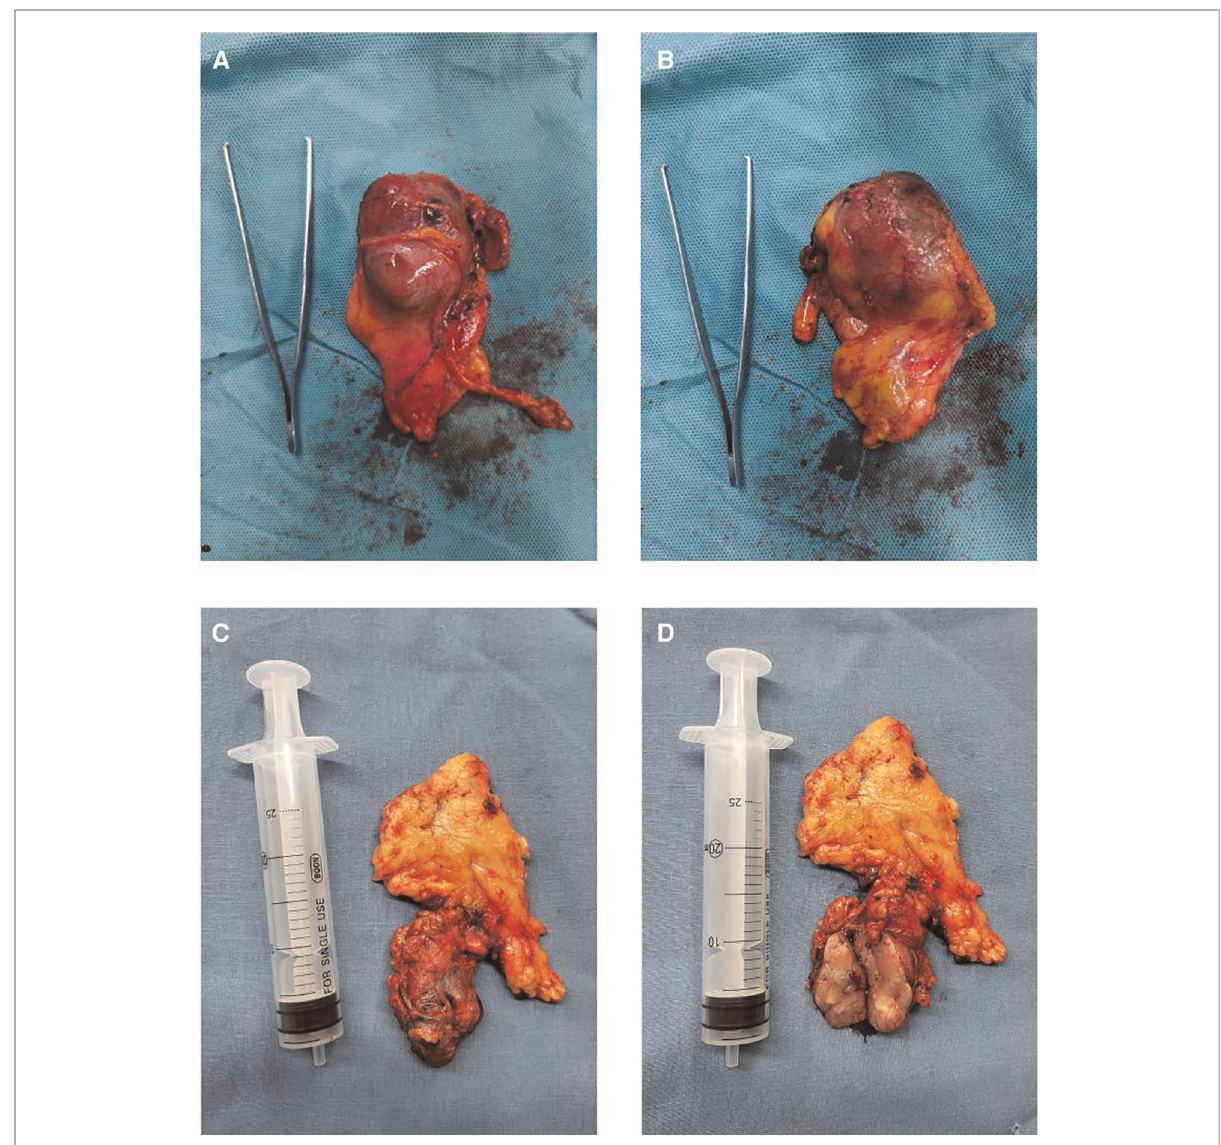
FIGURE 4 Resected goiters with surrounding tissues. Retrosternal goiters were photographed after resection. The specimen capsule is intact, and the tissue around the tumor was completely removed. Total thymectomy was performed sometimes ( C , D